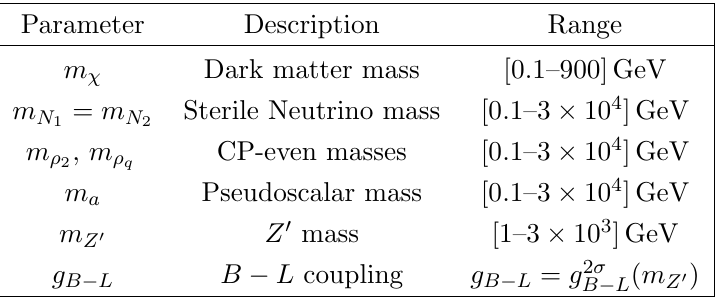
Table 3 . Ranges of the parameters explored for the non-minimal models. Values for m Z 0 were sampled using 154 logarithmically spaced points. The value of the g B (cid:0) L coupling was not taken as a free parameter, but instead (cid:12)xed to the collider 2 (cid:27) exclusion value for each m Z 0 value. For each point random values of m (cid:31) ; m N = m N ; m (cid:26) ; m (cid:26) ; m a were drawn from the range detailed in the 1 2 2 q table above (assuming a log-(cid:13)at distribution, except for m a in the q = 1 = 2 case where m a = 0), and tan (cid:12) or equivalently v 2 was set to be consistent with the measured relic abundance at 2 (cid:27) , i.e. (cid:10) DM h 2 = 0 : 120 0 : 003 [71]. We further require all coupling to be < p 8 (cid:25) in order for the model to (cid:6) remain perturbative. The total number of points in parameter space that meet such requirements are 1 : 54 10 5 for both the q = 1 = 2 and q = 1 cases. (cid:2) if the annihilation is dominated by (cid:31)(cid:31) NN the sterile neutrinos will decay to SM ! . 100 GeV are excluded from dwarf galaxies observations [88{90]. Dark particles, and m (cid:31) . 100 GeV are also excluded from gamma-ray observations in the case matter masses m (cid:31) that the annihilation is dominated by (cid:31)(cid:31) a (cid:26) , provided that the sterile neutrinos 2 ! are light enough, i.e. m < m = 2 ; m = 2. In the case that (cid:31)(cid:31) a (cid:26) dominates and (cid:26) a 2 N ! m > m = 2 ; m = 2, then the (cid:12)nal state will be entirely composed of light active (cid:26) a N